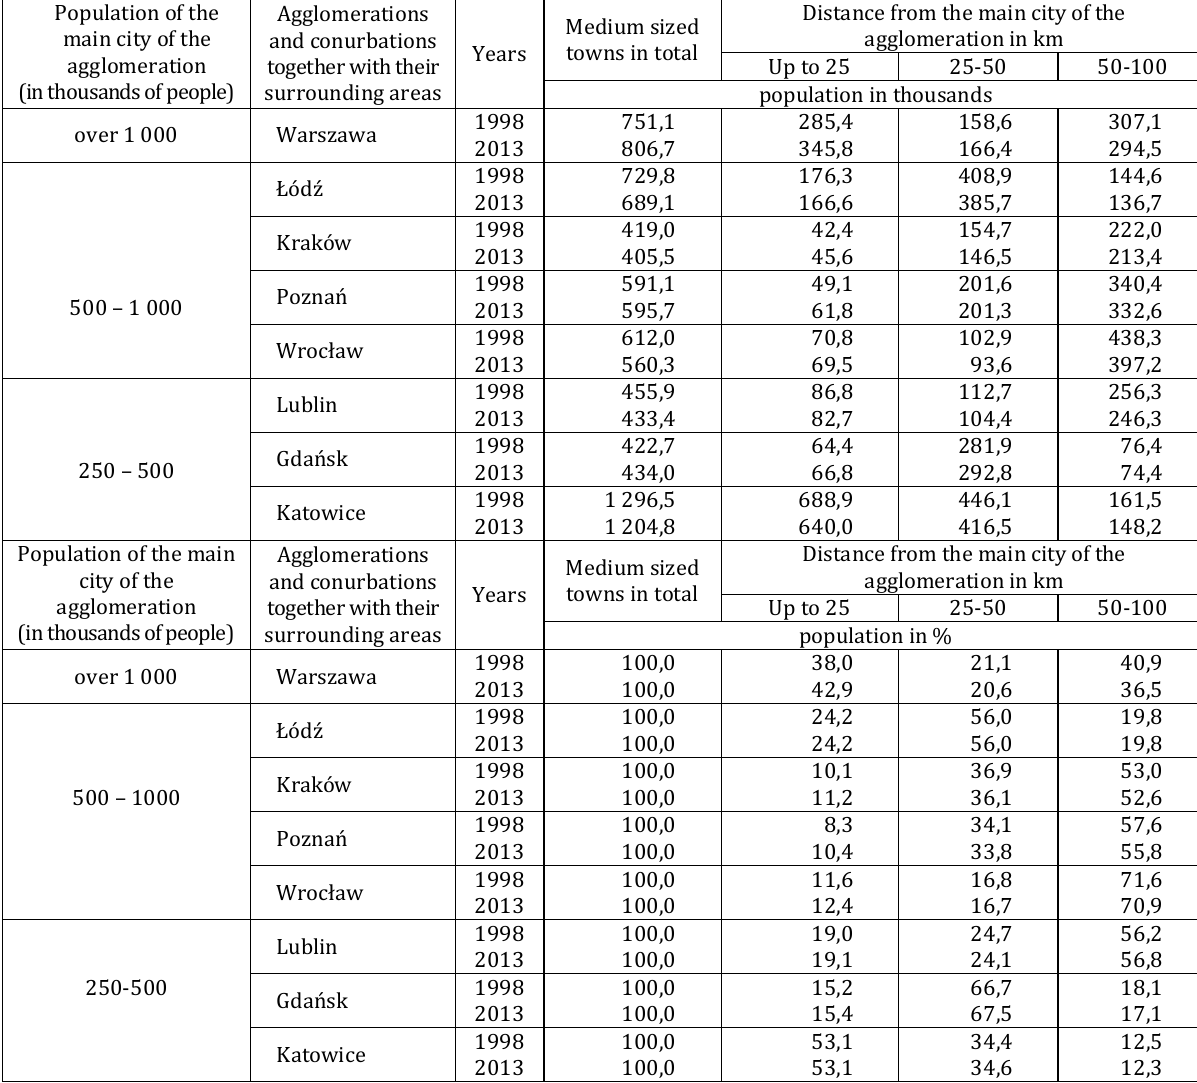
Table 2. Populations of medium sized towns by zones of the distance from the main